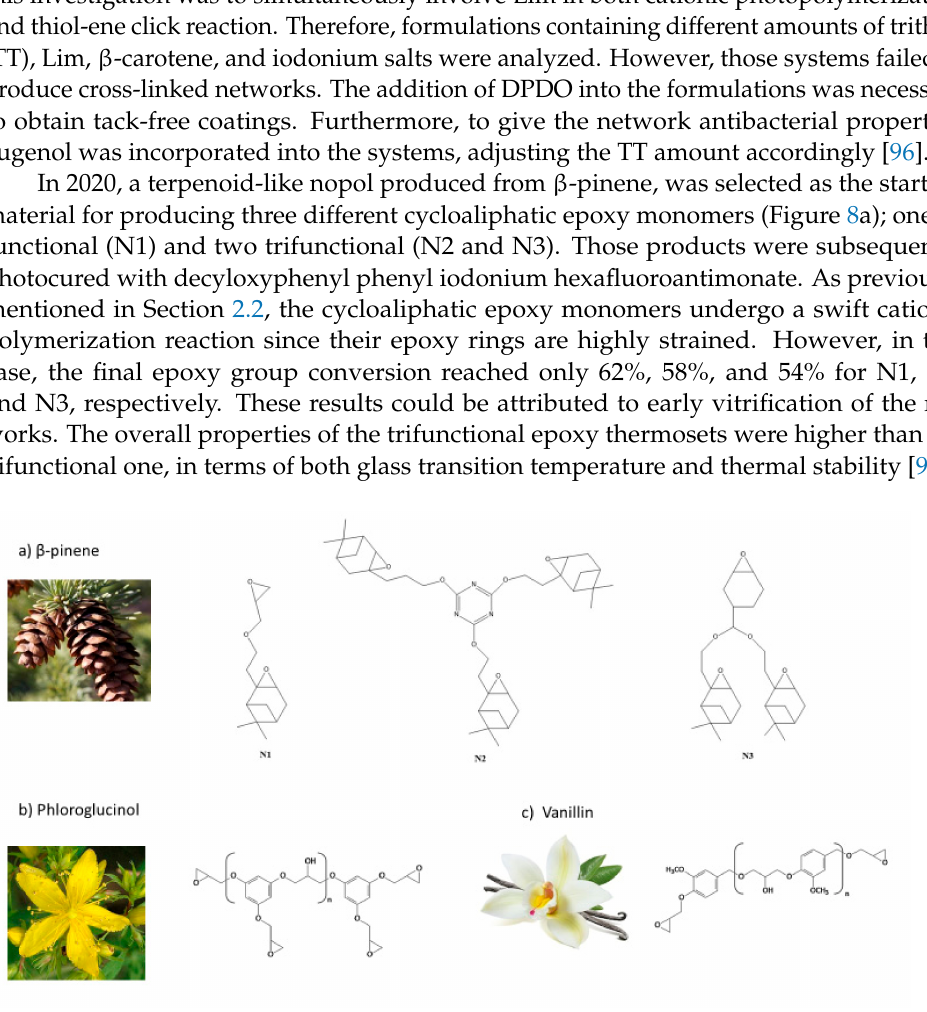
Figure 8. Epoxidized monomers derived by ( a ) β -pinene, ( b ) phloroglucinol and ( c )